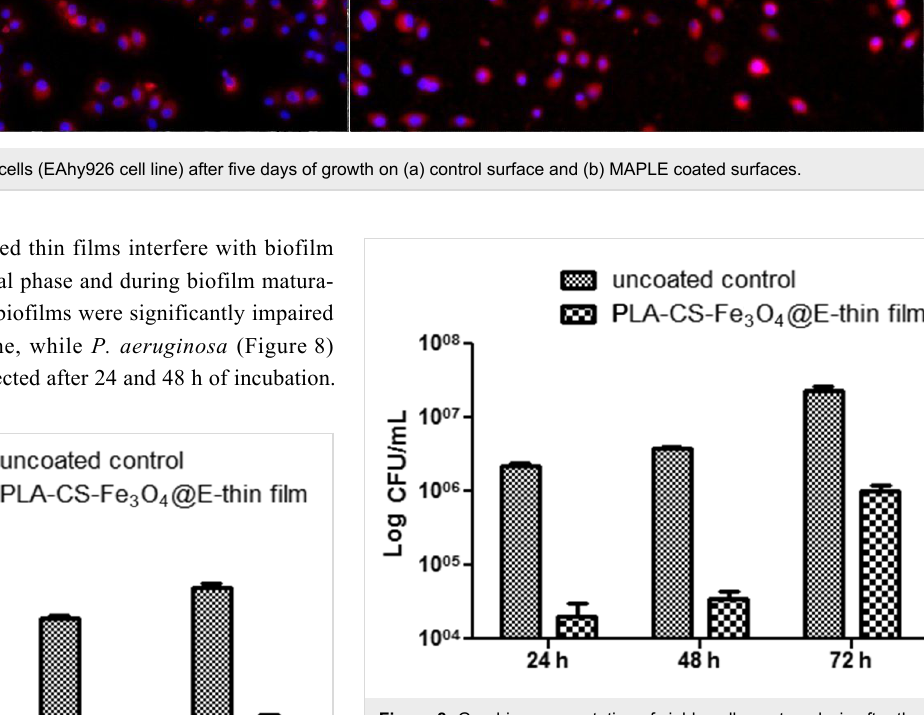
Figure 8: Graphic representation of viable cell count analysis after the removal of P. aeruginosa biofilm embedded cells 24 h, 48 h and 72 h post-infection (PLA-CS-Fe 3 O 4 @EUG thin coatings vs uncoated control; CFU/mL = colony forming